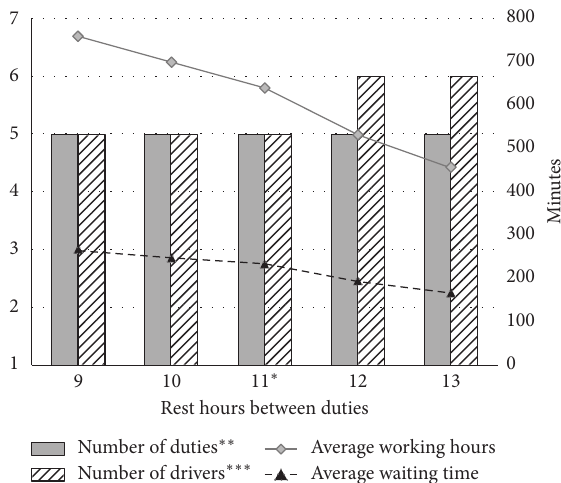
Figure 14: Sensitivity analysis of the minimum number of minutes to be considered as a break. Note . ∗ Current value and comparison basis. ∗∗ The number of duties required to cover the timetable. ∗∗∗ The number of drivers required for the